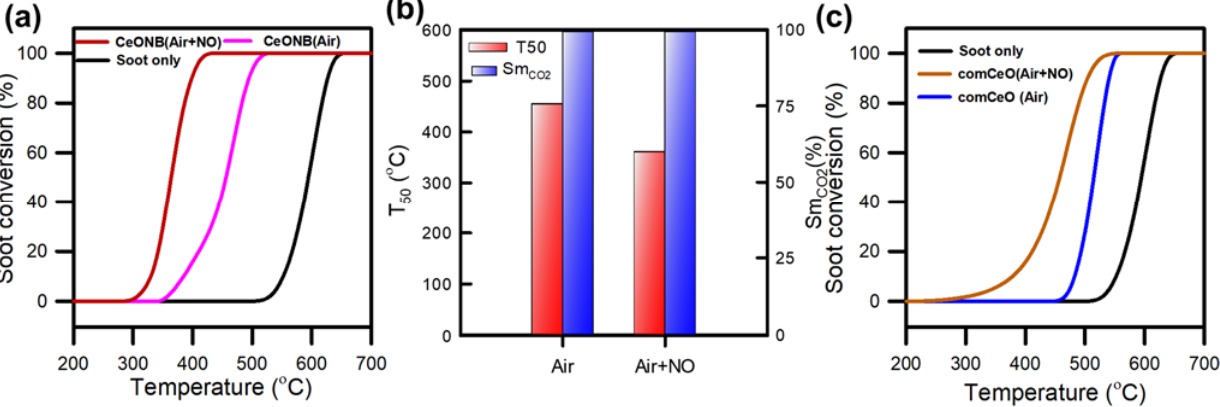
Figure 10. Effect of NO on soot oxidation by CeONB: ( a ) soot conversion (%) and ( b ) T 50 and S mCO2 ; ( c ) the TPO profile of comCeO with/without NO.